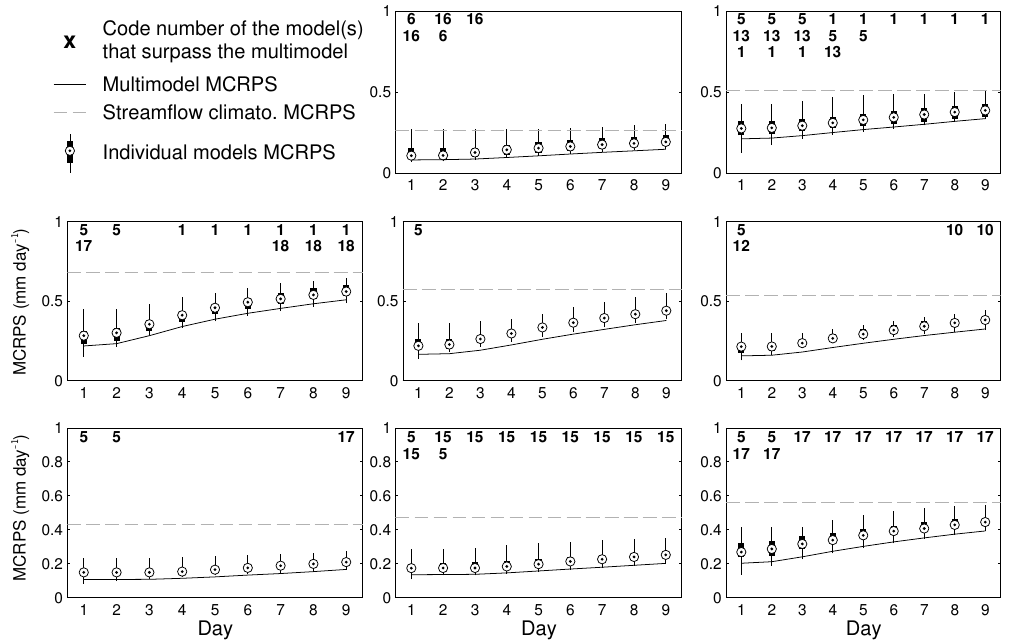
Figure 10. Comparative examples of the MCRPS on eight catchments of the EnKF individual models and the EnKF multimodel, both using MEPS forcing (system D vs.